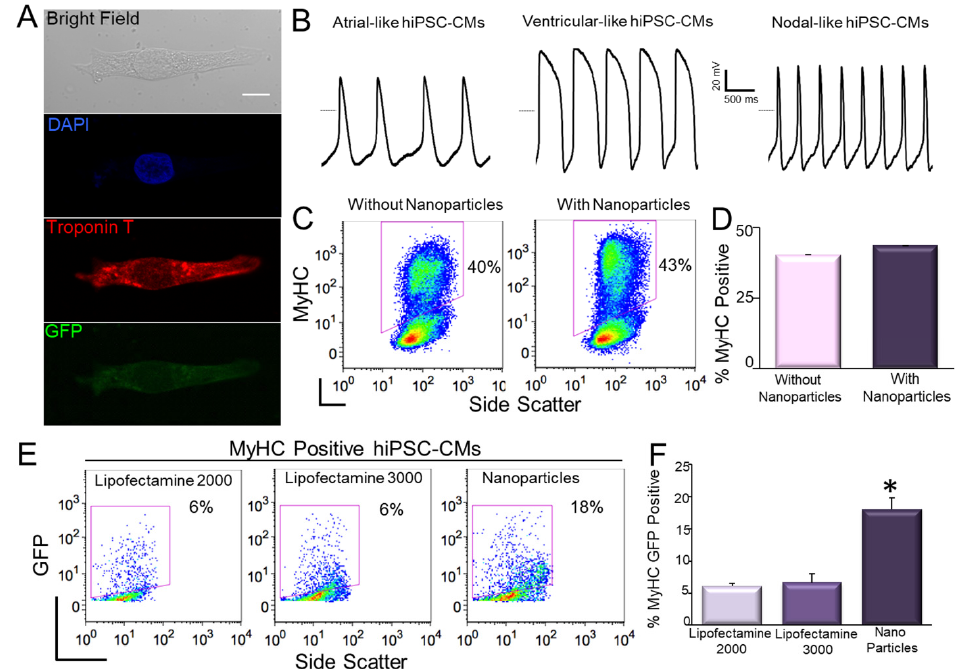
Figure 9. Transfection of hiPSC-CMs using magnetic nanoparticles [78]. ( A ). Confocal laser scanning microscopic images of GFP-transfected hiPSC-CM. Scale bar is 10 µm. ( B ). hiPSC-CMs exhibit spontaneous APs with ventricular-like, atrial-like, and nodal-like characteristics. The dotted line represents 0 mV. ( C , D ) Assessment of the efficiency of differentiation into cardiomyocytes (CMs) in control hiPSCs compared to hiPSCs transfected with double fusion construct using magnetic nanoparticles by analysis of myosin heavy chain (MyHC) positive cells. Summary data are shown in the right panels. ( E , F ) Comparison of the transfection efficiency in double positive hiPSC-CMs (MyHC + /GFP + ) using pIRES2-EGFP vector and lipofectamine-2000, -3000, and nanoparticle-mediated magnetofections. Data were collected 4 h after transfection (* p < 0.05, n = 3).